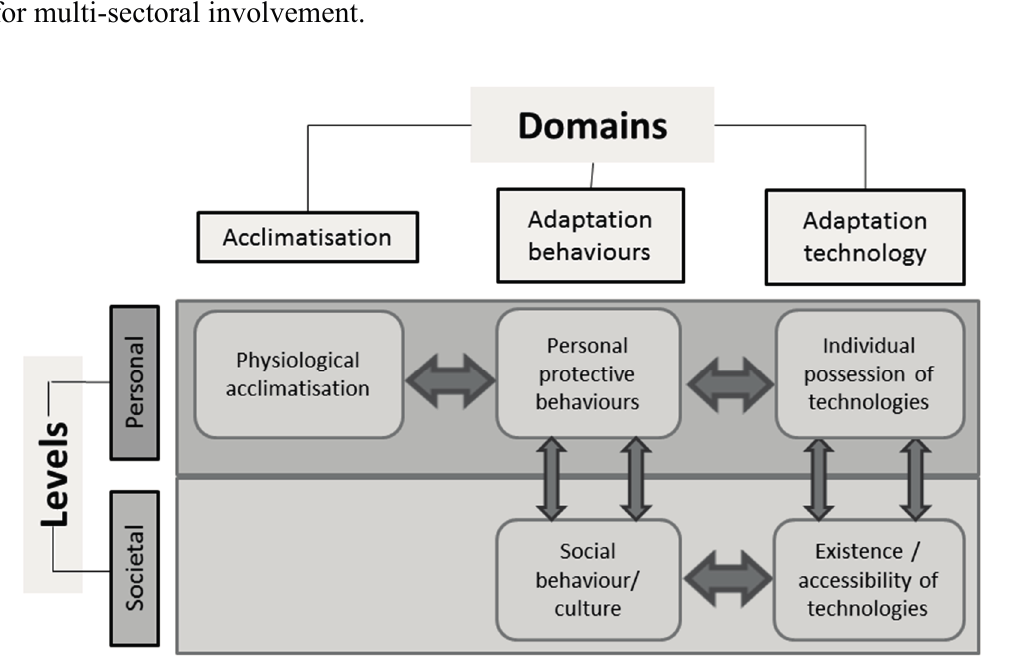
Figure 2. Climate change adaptation conceptual framework. This Climate Change Adaptation Conceptual Framework comprises three domains, (acclimatisation, adaptation behaviours and technology) which operate at societal or personal levels. Subsystem elements (see Figure 3) within each of the five cells, interact with elements in other cells, across the three domains and two levels, under the influence of external factors, such as a planned policy intervention, to produce